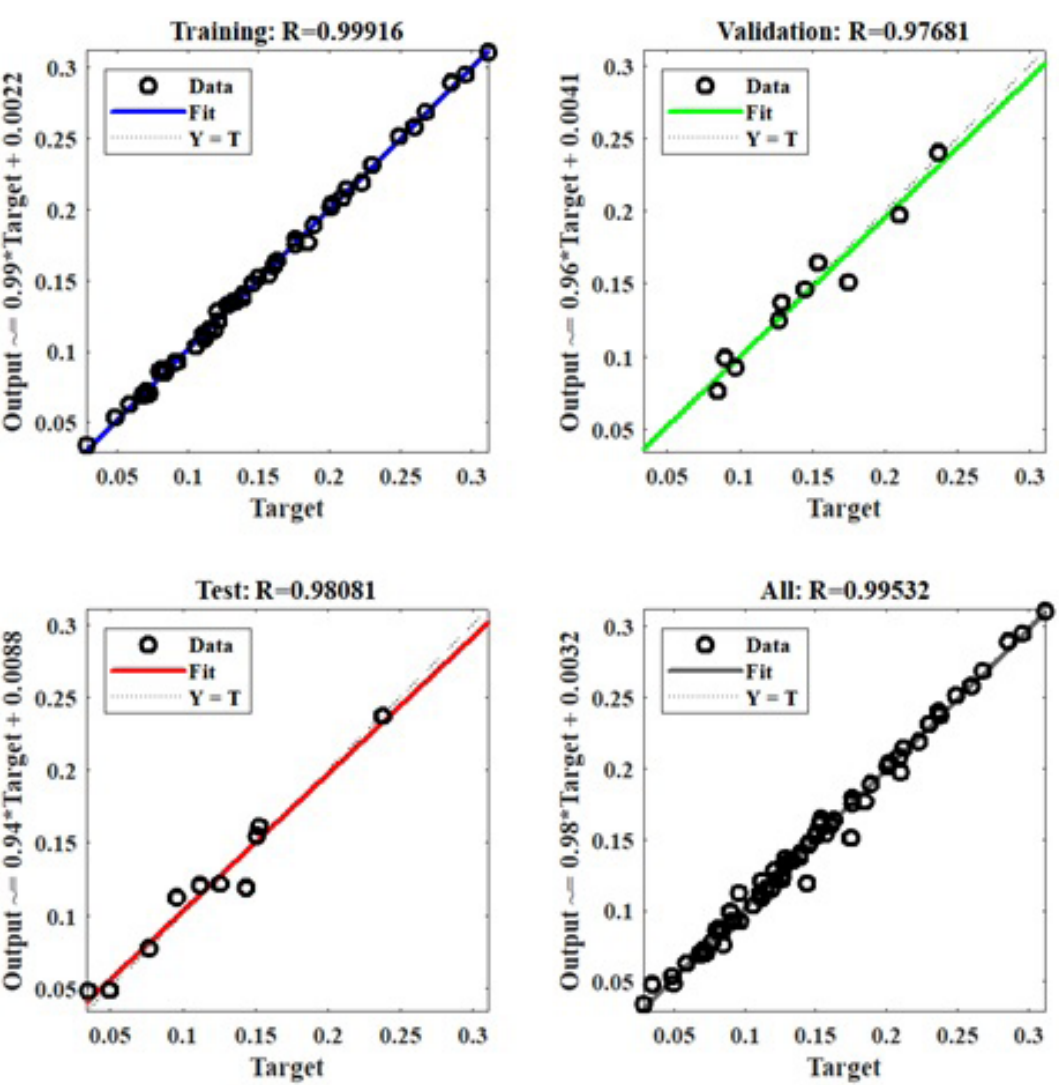
Figure 15. Percentage accuracy of the ANN model on the training, validation, testing stages, and wth the overall samples.